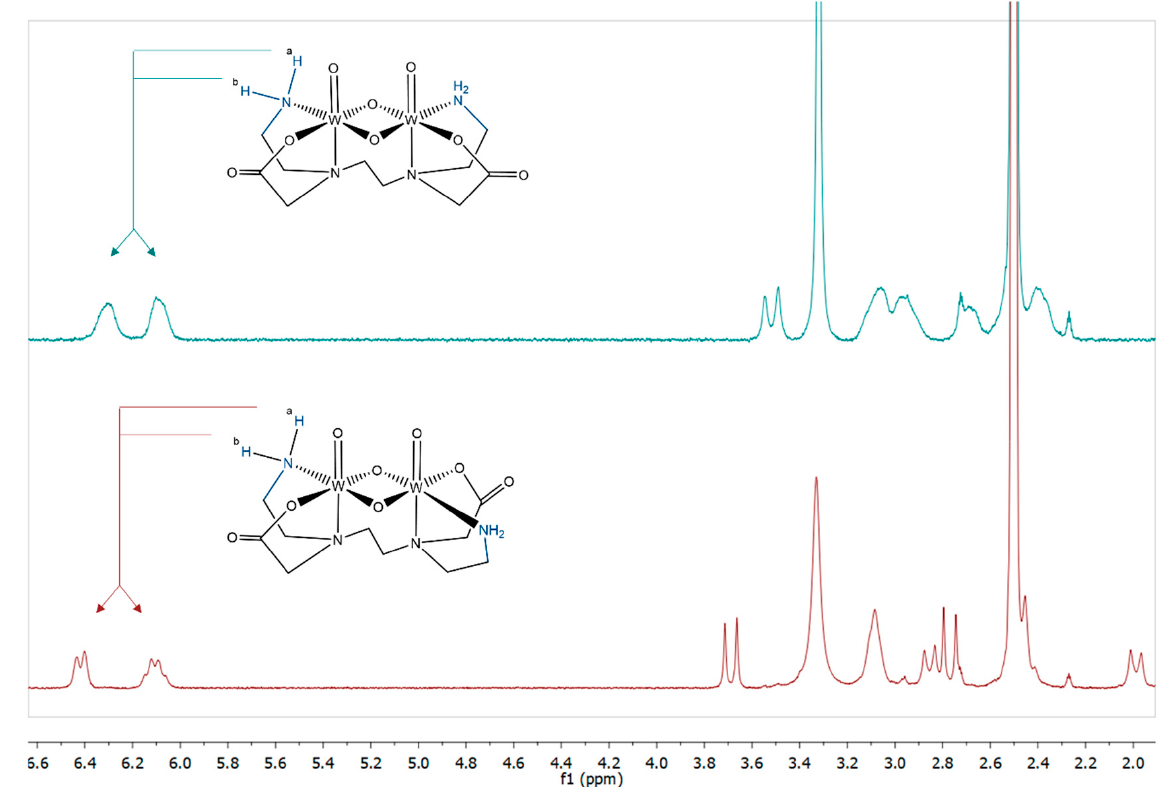
Figure 4. 1 H NMR spectra of both isomers of [W 2 O 4 (L2)] ( 2a top and 2b bottom) in DMSO-d 6 at RT; the structure of the cis isomer ( 2a ) was confirmed by X-ray crystallographic analysis. The two NH 2 protons in both 2a and 2b are chemically non-equivalent, and thus give rise of two signals in the region of 6.0–6.6 ppm (see also Figure S9). The spectra in the region below 4 ppm display a complex pattern as a result of the several ethylene and methylene moieties present in the